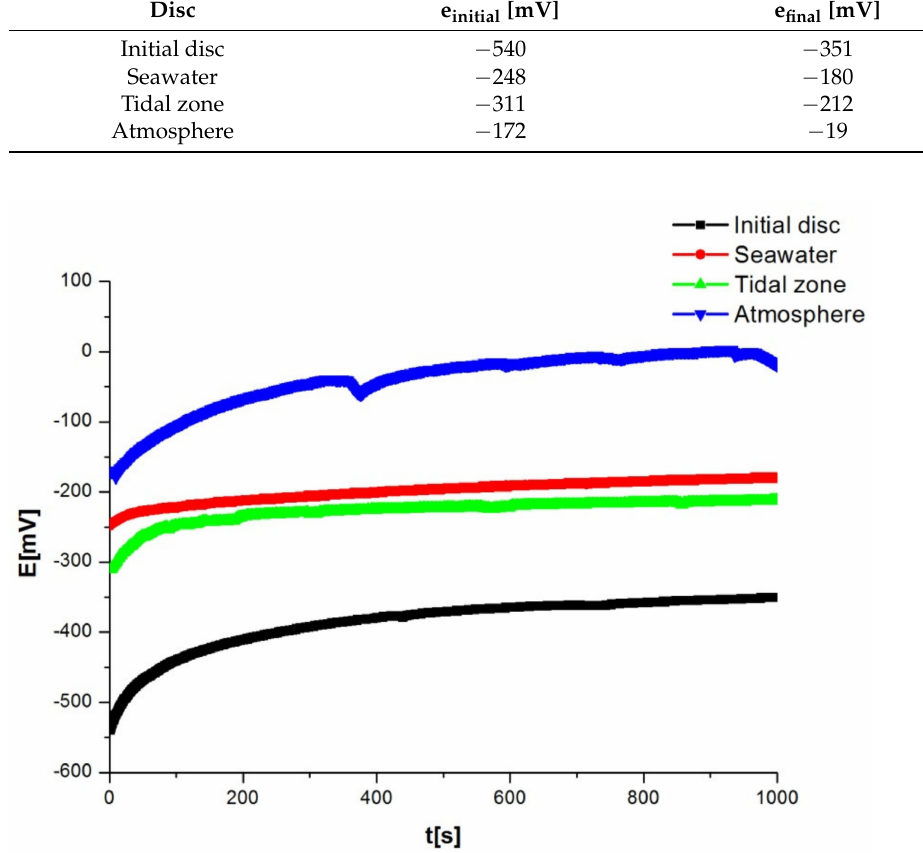
Figure 6. Results obtained by changing the corrosion potential as a function of